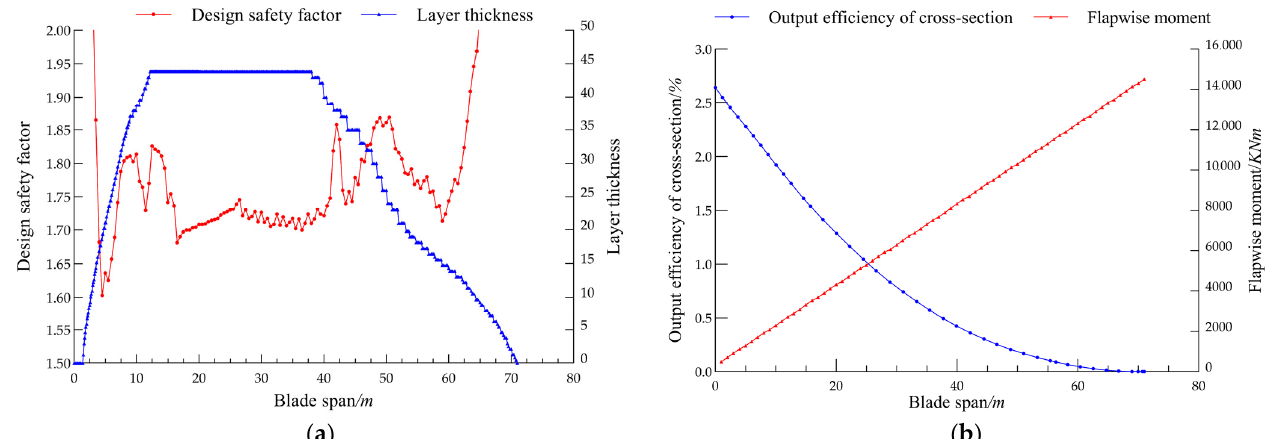
Figure 3. Blade design distribution of B71: ( a ) spar cap layering thickness and safety factor; ( b ) ultimate flapwise moment and output efficiency of blade.